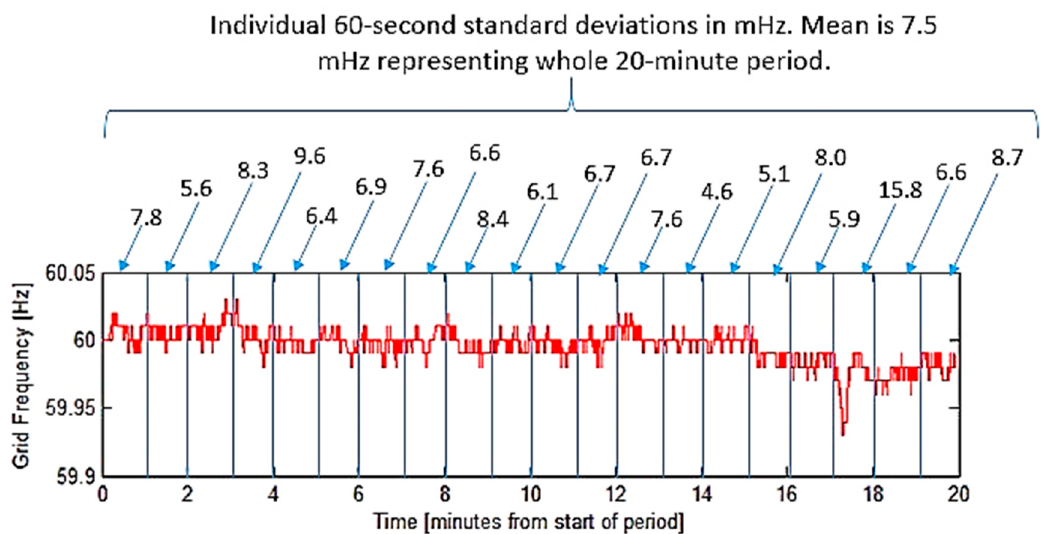
Figure 4. Methodology to determine the frequency variability metric. The red line shows grid frequency from one 20-min period. Small numbers above graph represent standard deviation of each one-minute window. The mean of those standard deviations (in this case, 7.5 mHz) is used to characterize the entire 20-min period.